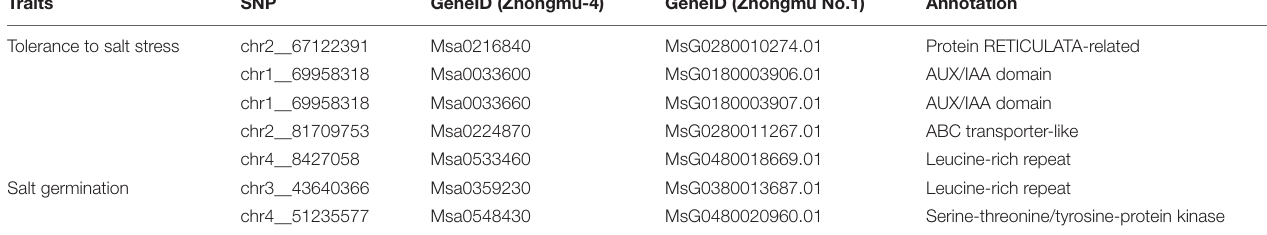
TABLE 2 | Candidate genes associated with tolerance to salt stress and germination ability under salt stress. Traits SNP GeneID (Zhongmu-4) GeneID (Zhongmu